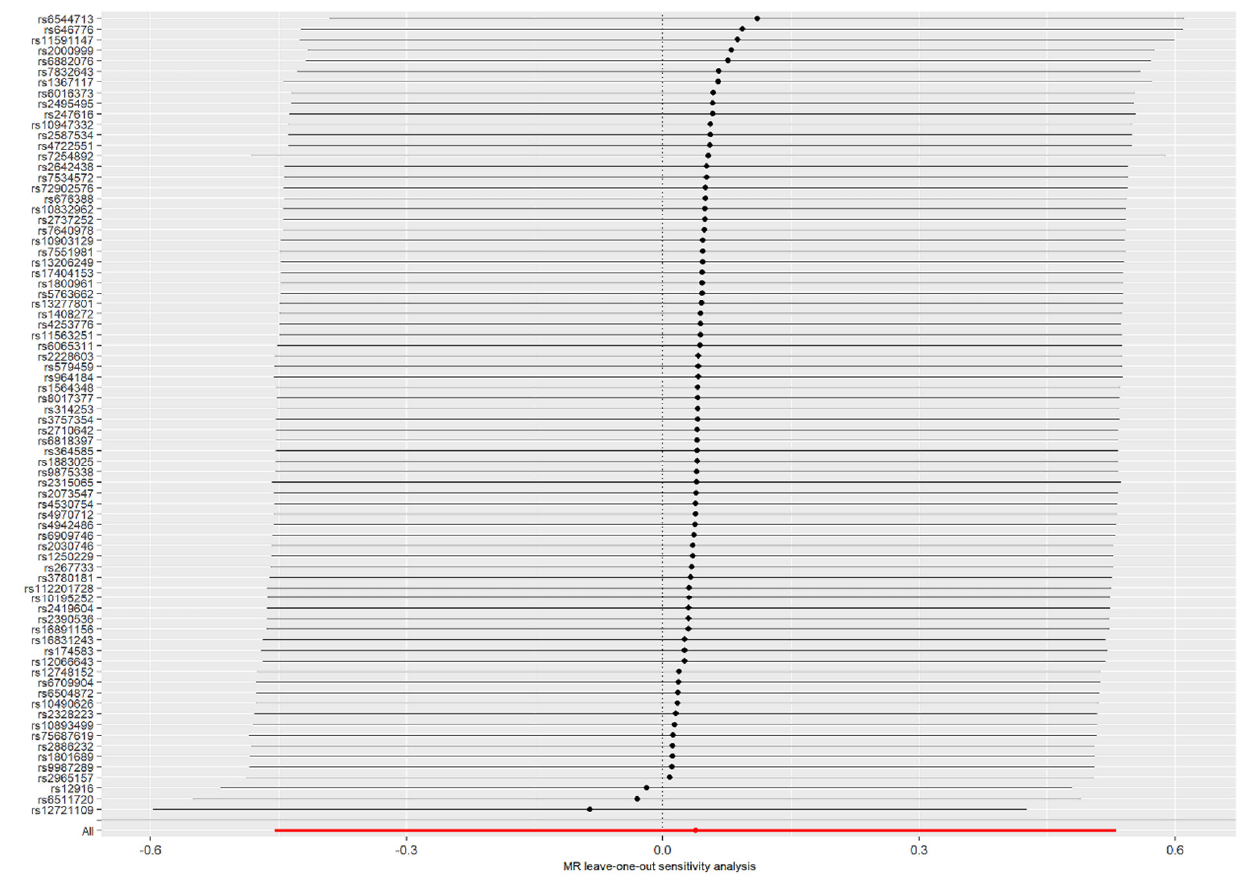
Figure 2. MR leave-one-out sensitivity analysis for low-density lipoprotein cholesterol on residual age at onset of